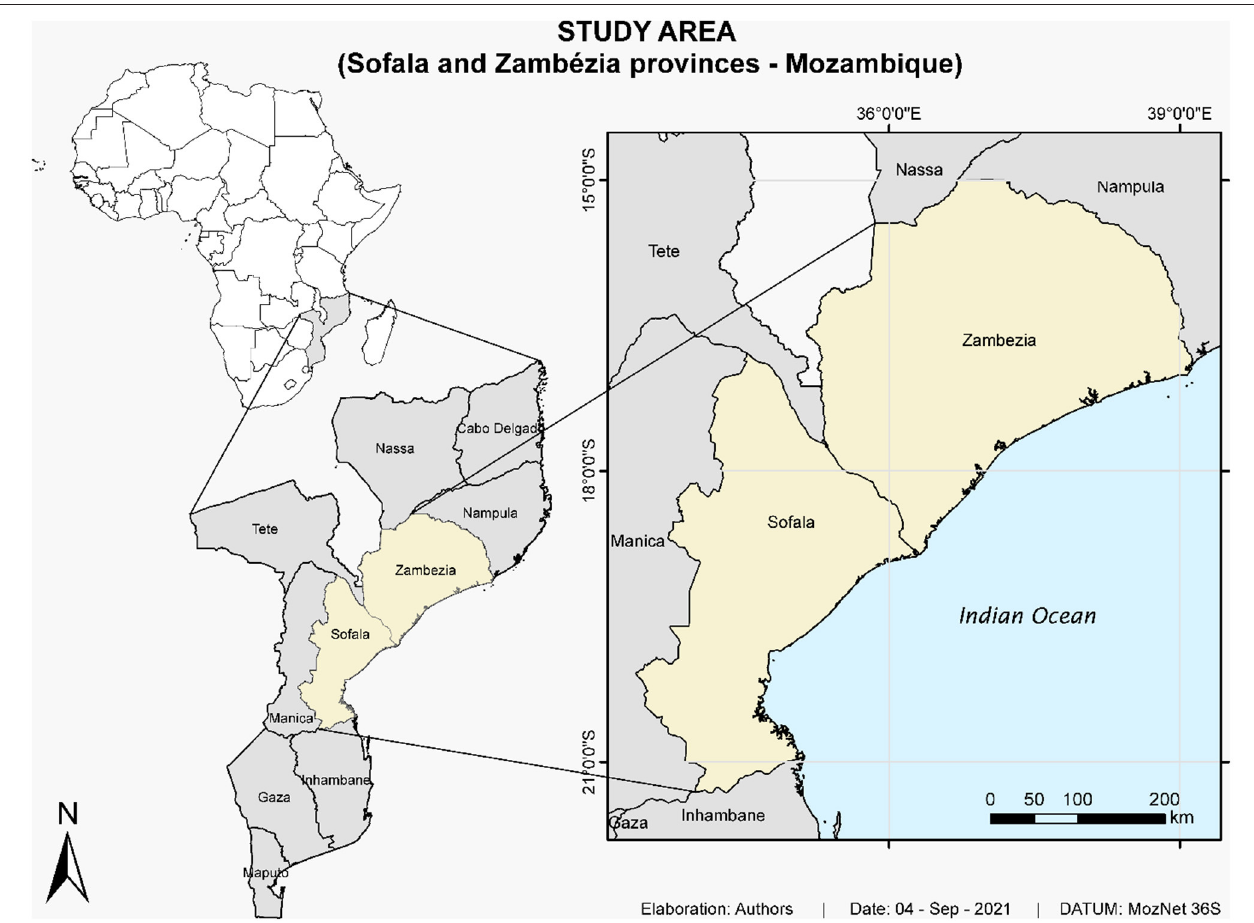
FIGURE 1 | Map showing the Province of Sofala and Zambezia and all the locations of the districts covered in the study. Source: